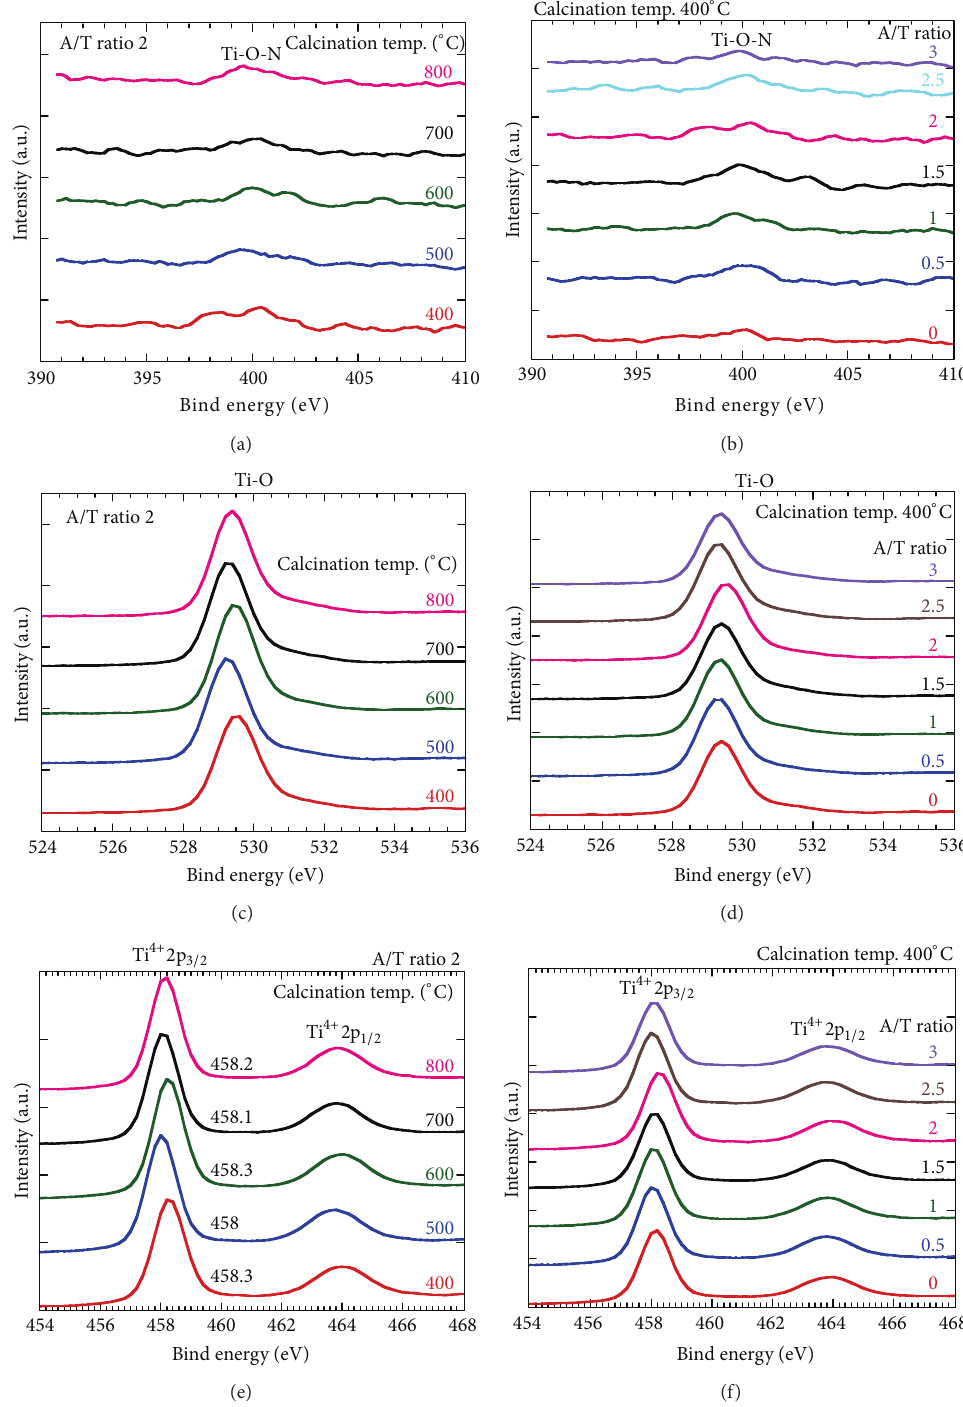
Figure 7: XPS survey and core level spectra of (a)-(b) N 1s, (c)-(d) Ti 2p, and (e)-(f) O 1s of N-TiO 2 samples.